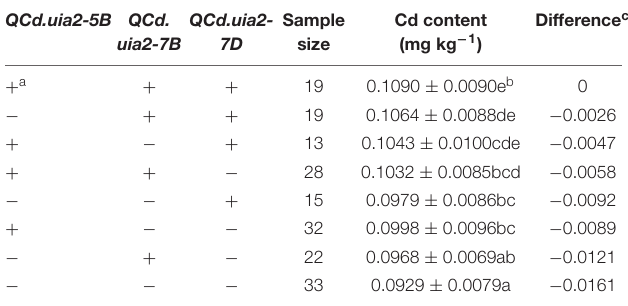
TABLE 5 | Additive effects of the QTL on 5B, 7B, and 7D for Cd content (mg kg − 1 ) in grain across sites in the UI Platinum × LCS Star-derived double haploid population.